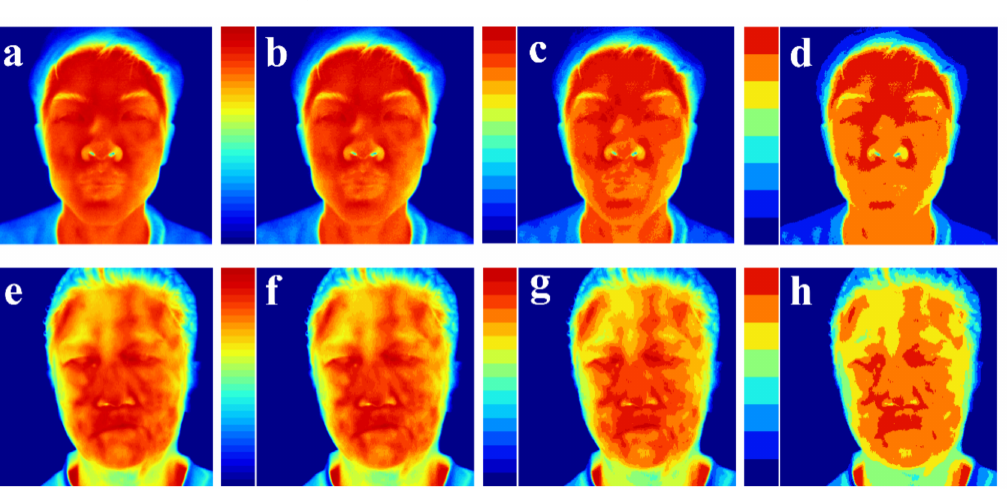
Figure 5. Comparison of facial thermal images between healthy subject and patient with facial paralysis using different pseudo-color methods. ( a – d ) are images of the healthy subject, while ( e – h ) are for the patient with facial paralysis. According to the given lower and upper temperature limits, the temperature values of all pixels in the thermal image are divided from low to high into 64 layers ( a , e ), 32 layers ( b , f ), 16 layers ( c , g ) and 8 layers ( d , h ), where each pixel is given a pseudo-color according to the level of its temperature